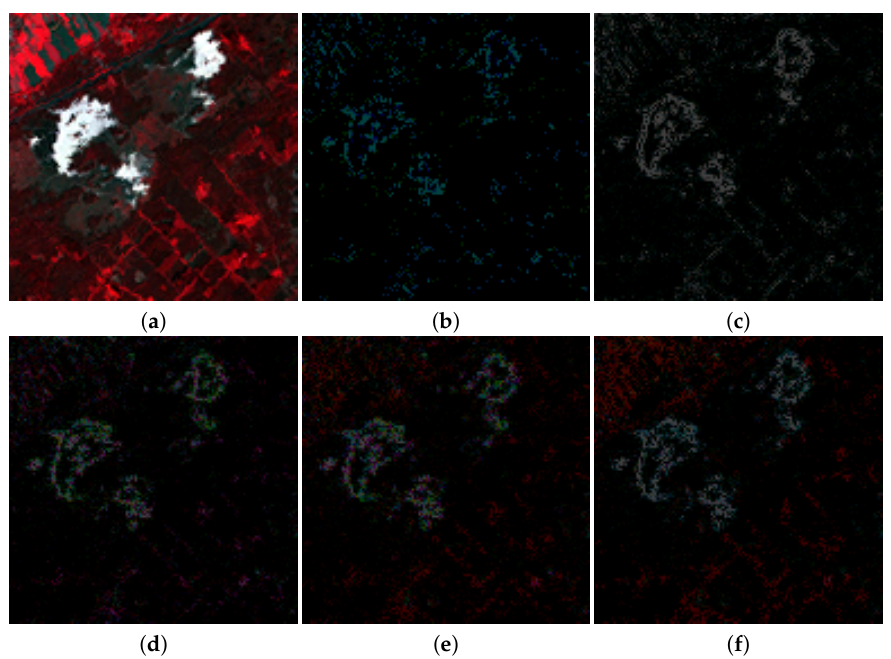
Figure 5. ( a ) Ground truth 128 × 128 image from Figure 2a. The normalized maximum absolute error minus the absolute error images images for the following methods, ( b ) Partial Replacement Adaptive Component Substitution (PRACS), ( c ) modulation transfer functions (MTF)-generalized Laplacian pyramid (GLP)-context based decision (CBD), ( d ) Total Variation (TV), ( e ) (cid:96) 1 and ( f )